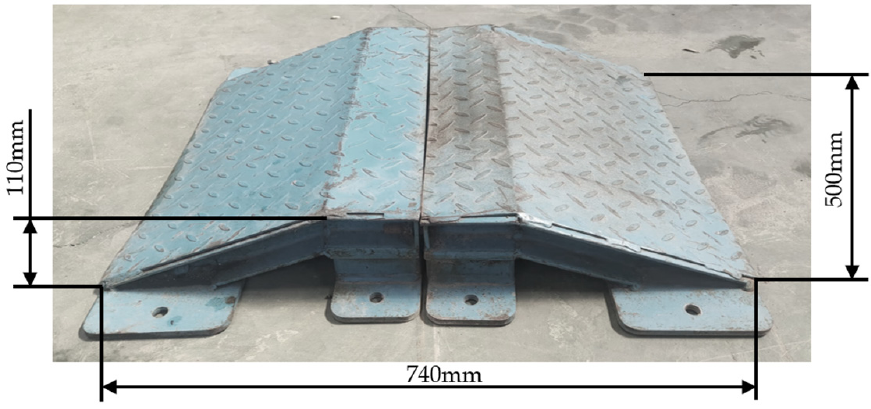
Figure 11. Test vehicle and site.